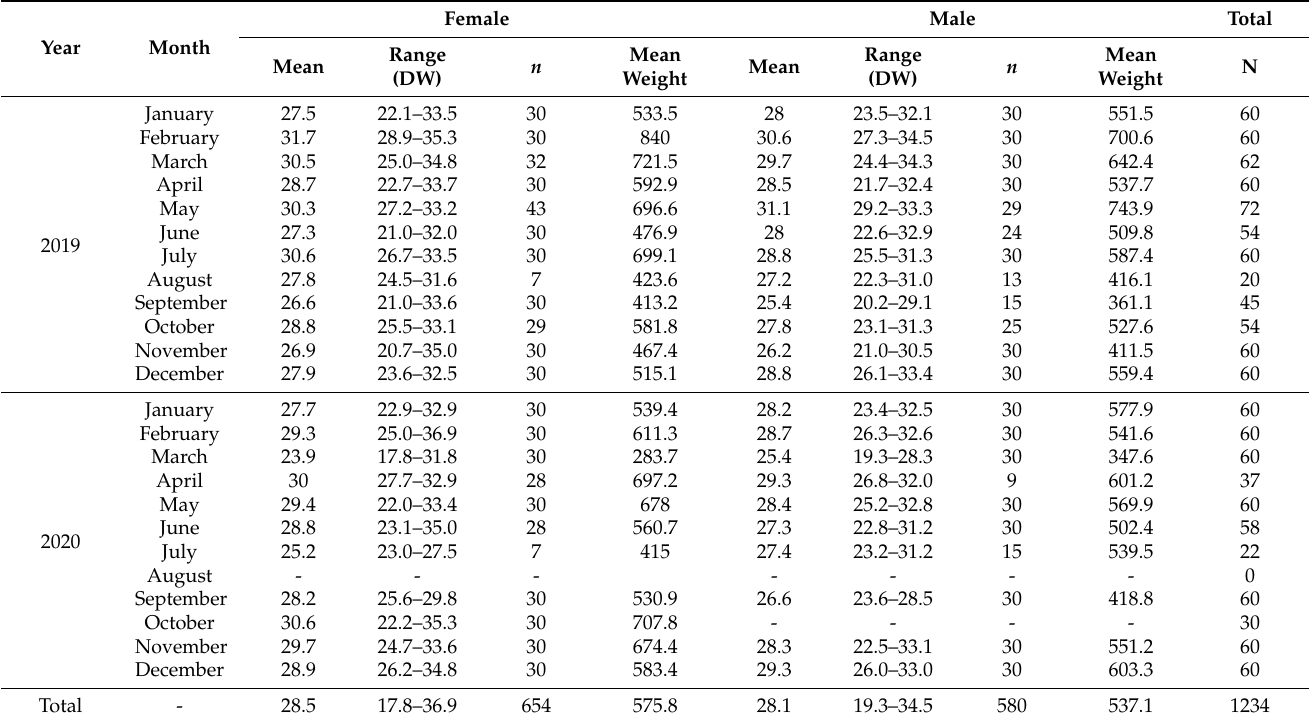
Table 1. Mean and range of DW (cm) and weight (g) of ocellate spot skate Okamejei kenojei specimens ( n ) collected from the West Sea of Korea in 2019 and 2020.